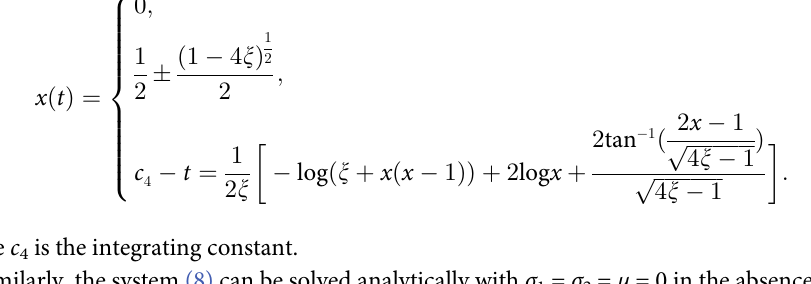
ffiffiffiffiffiffiffiffiffiffiffiffiffiffi p 4 x (cid:0) 1